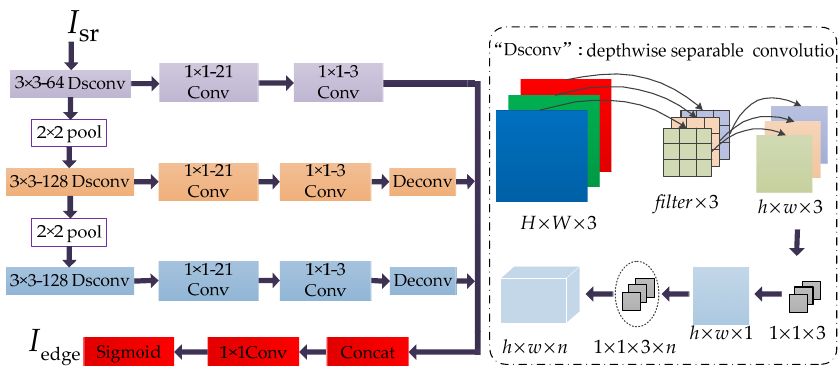
Figure 4. Our proposed edge enhanced network (EdgeNet). “Dsconv” means depth-wise separable convolution, and its calculation flow is shown in the inside of the dotted box. “Deconv” means deconvolution, and “pool” means pooling layer. “ k × k − n ” means the kernel size of this layer is k and the number of filters is n .